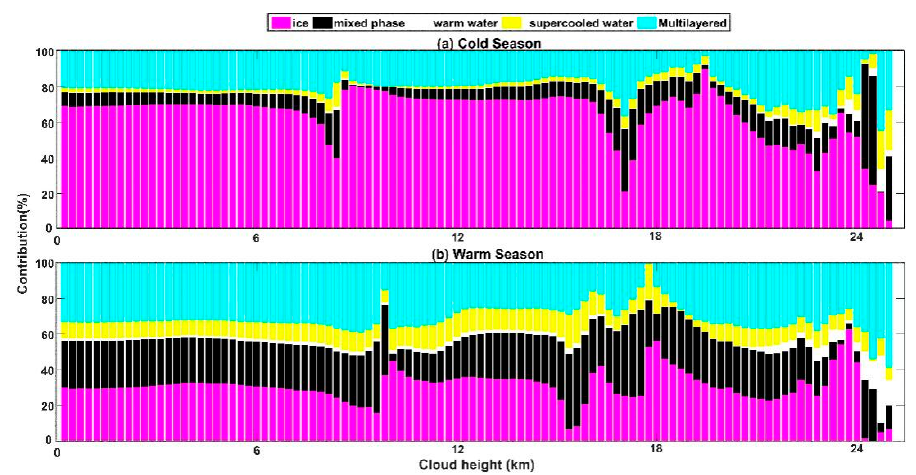
Figure 8. Vertical distribution of the net heating rate contribution from different cloud phases (( a ) represents the cold season and ( b ) represents the warm season. Each season contains four different single-layer cloud phases and multilayered cloud).